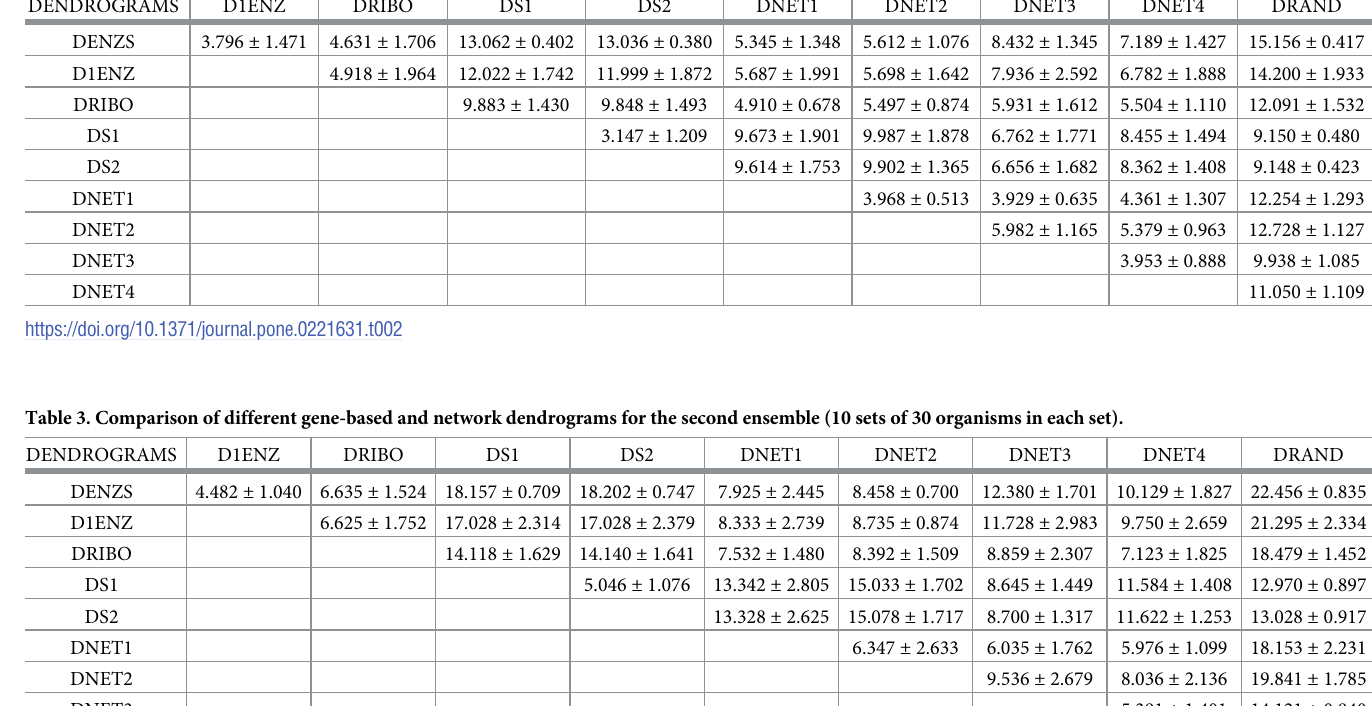
Table 2. Comparison of different gene-based and network dendrograms for the first ensemble (10 sets of 20 organisms in each set). DENDROGRAMS